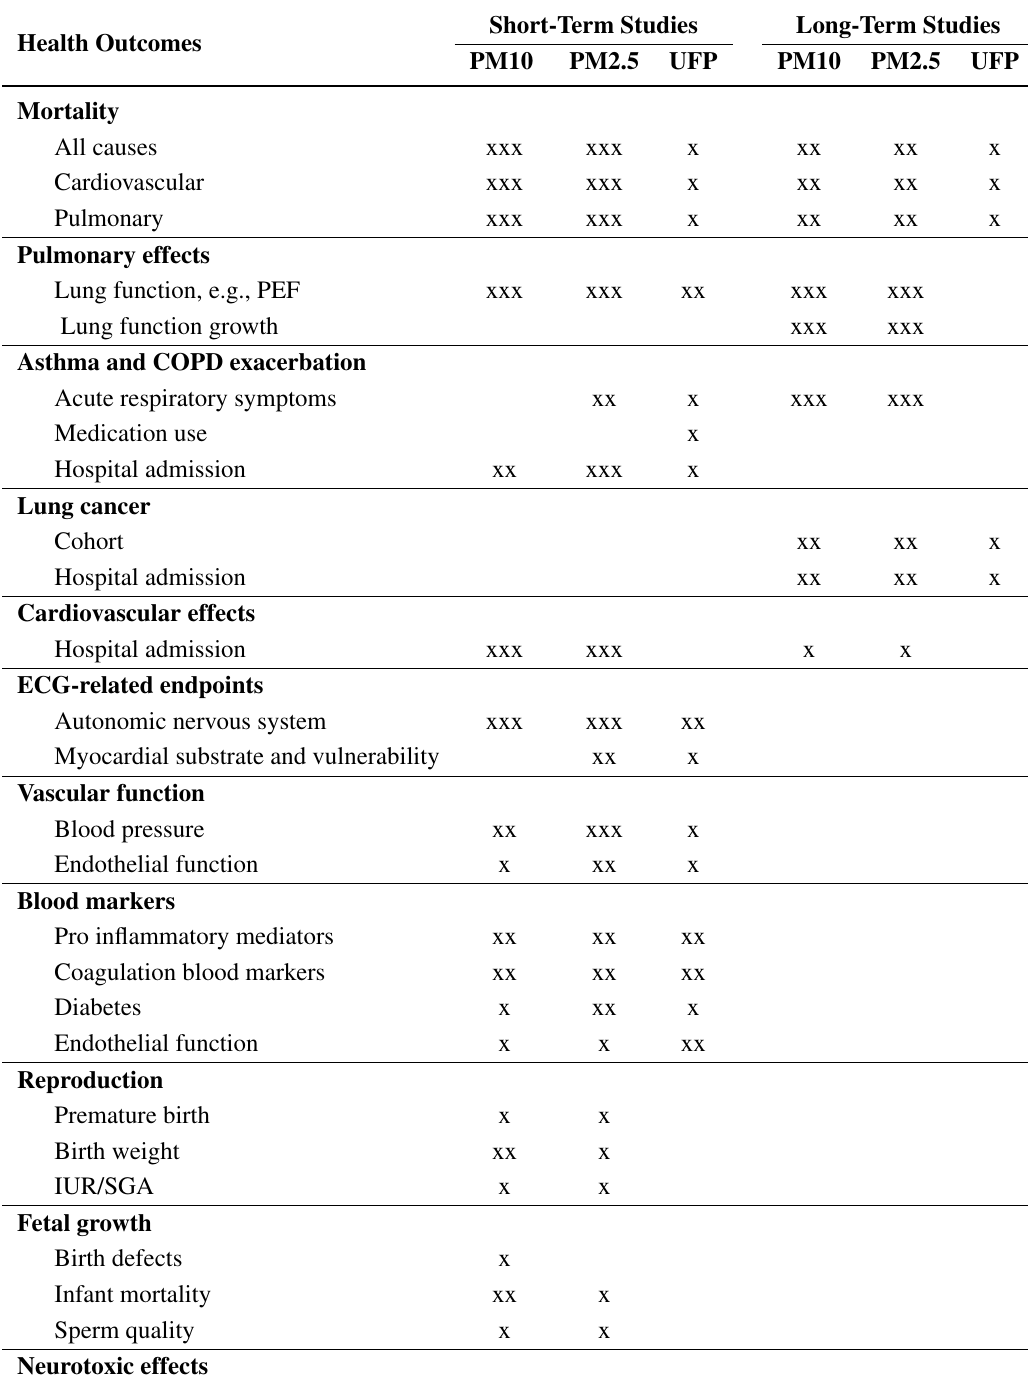
Table 1. Health outcomes associated with particulate matter (PM) and ultra-fine particles (UFP) (modified from